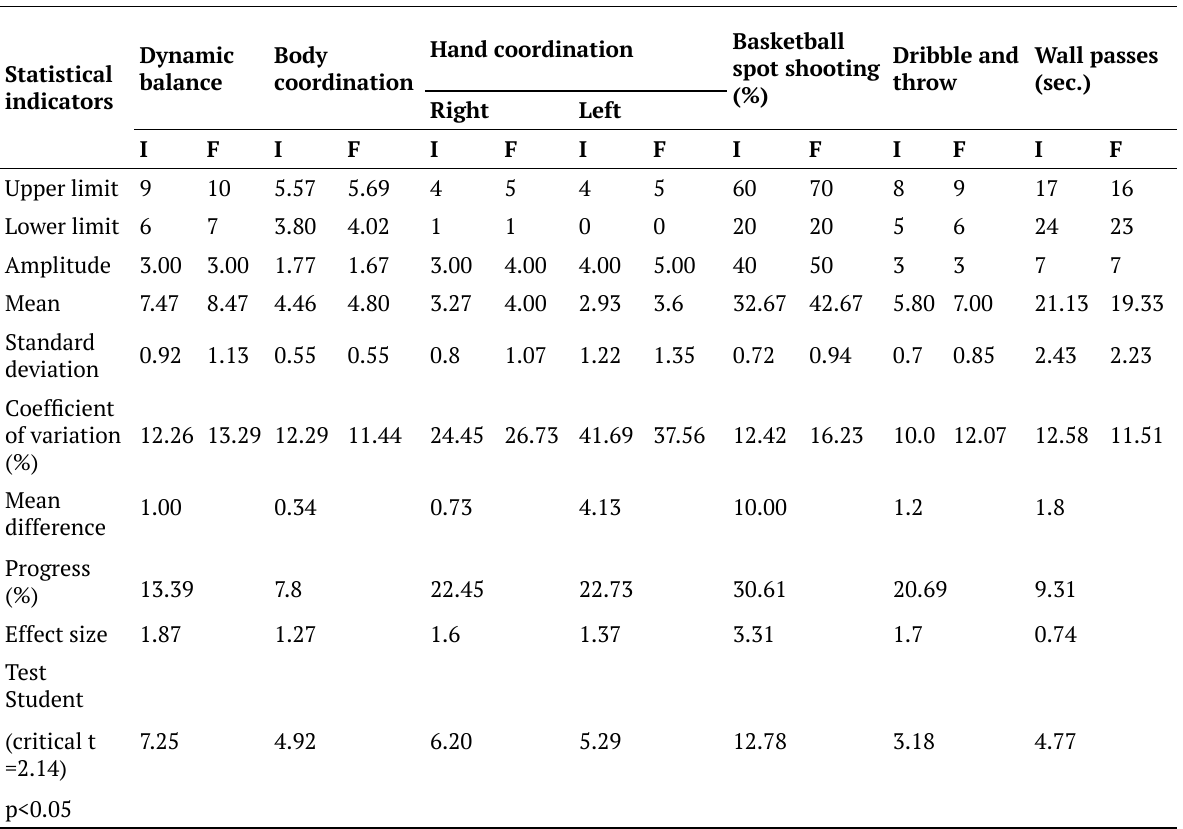
Table 2. Statistical processing